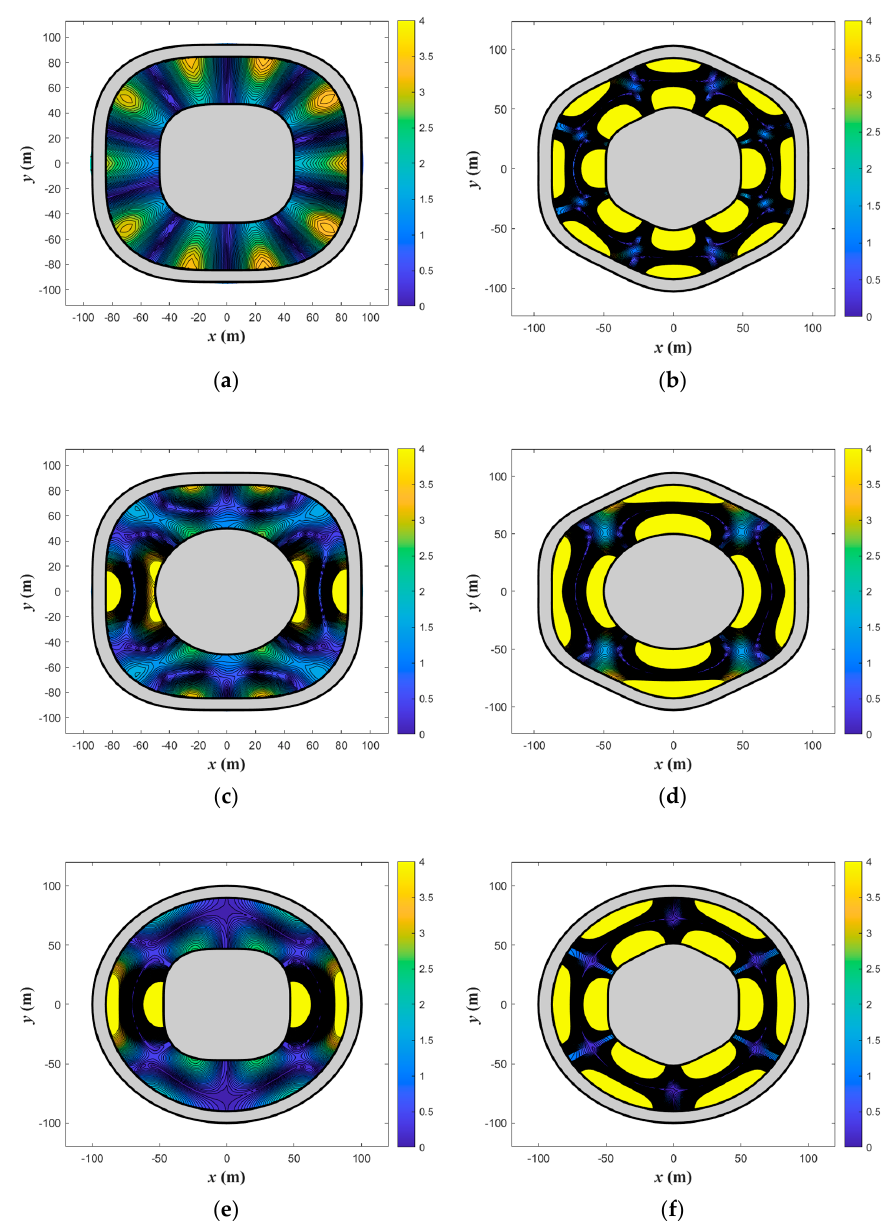
Figure 11. Normalised inner wave fields for various combinations of individually oscillating float ‐ ing platforms and ring structures at significant resonance frequencies: ( a ) square platform and square ring ( (cid:1863)(cid:1860) (cid:3404) 3.75 ); ( b ) hexagonal platform and hexagonal ring ( (cid:1863)(cid:1860) (cid:3404) 5.25 ); ( c ) circular platform and square ring ( (cid:1863)(cid:1860) (cid:3404) 5.25 ); ( d ) circular platform and hexagonal ring ( (cid:1863)(cid:1860) (cid:3404) 4.5 ); ( e ) square platform and circular ring ( (cid:1863)(cid:1860) (cid:3404) 4.75 ); ( f ) hexagonal platform and circular ring ( (cid:1863)(cid:1860) (cid:3404) 4.75